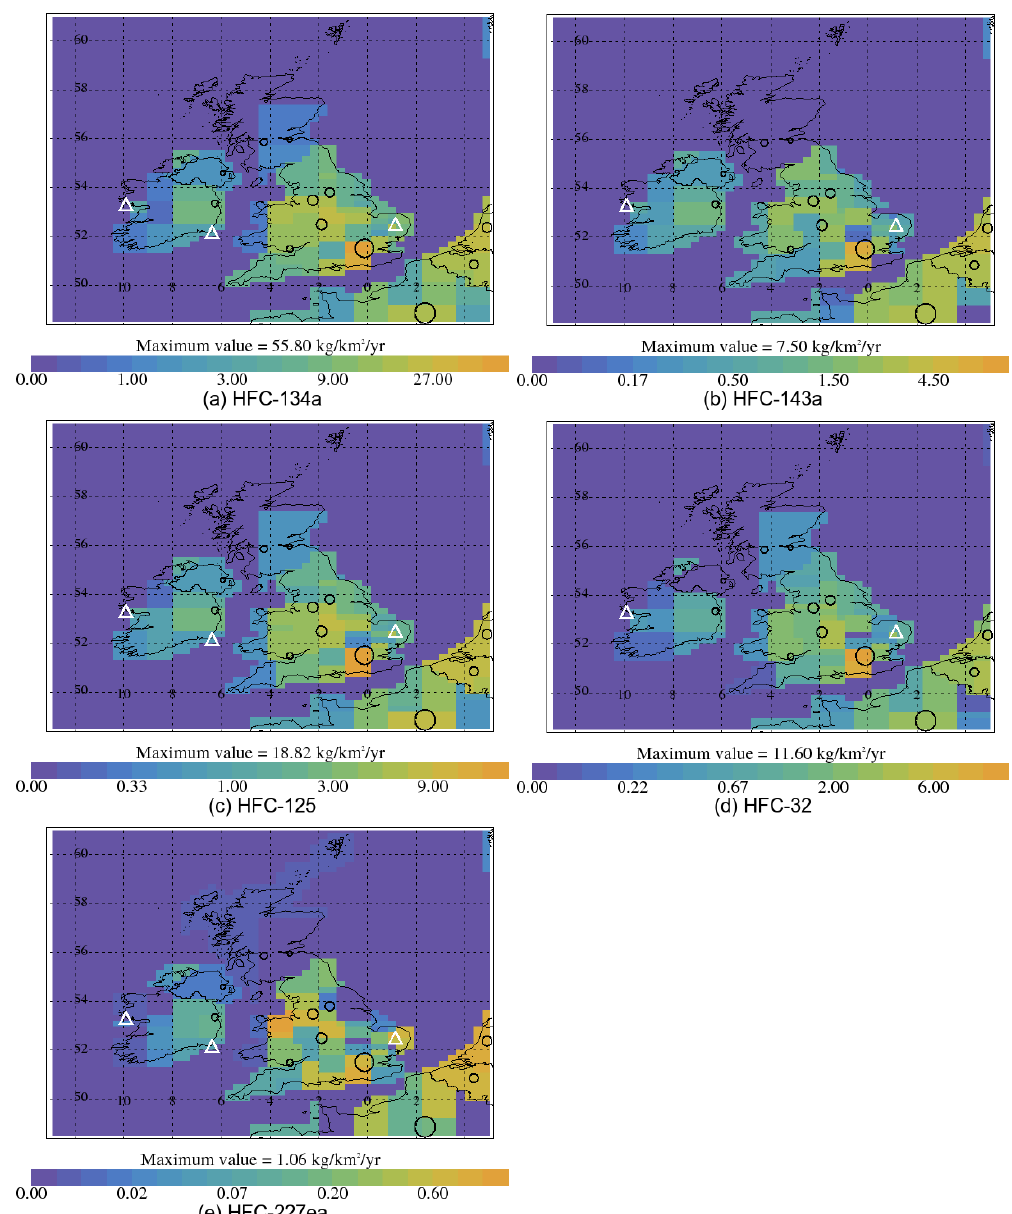
Figure 6. Two-year average InTEM emission estimate 2019–2020 (kgkm − 2 yr − 1 ) (a) HFC-134a, (b) HFC-143a, (c) HFC-125, (d) HFC-32 and (e) HFC-227ea. Black circles represent major cities, and white triangles show the locations of the observation